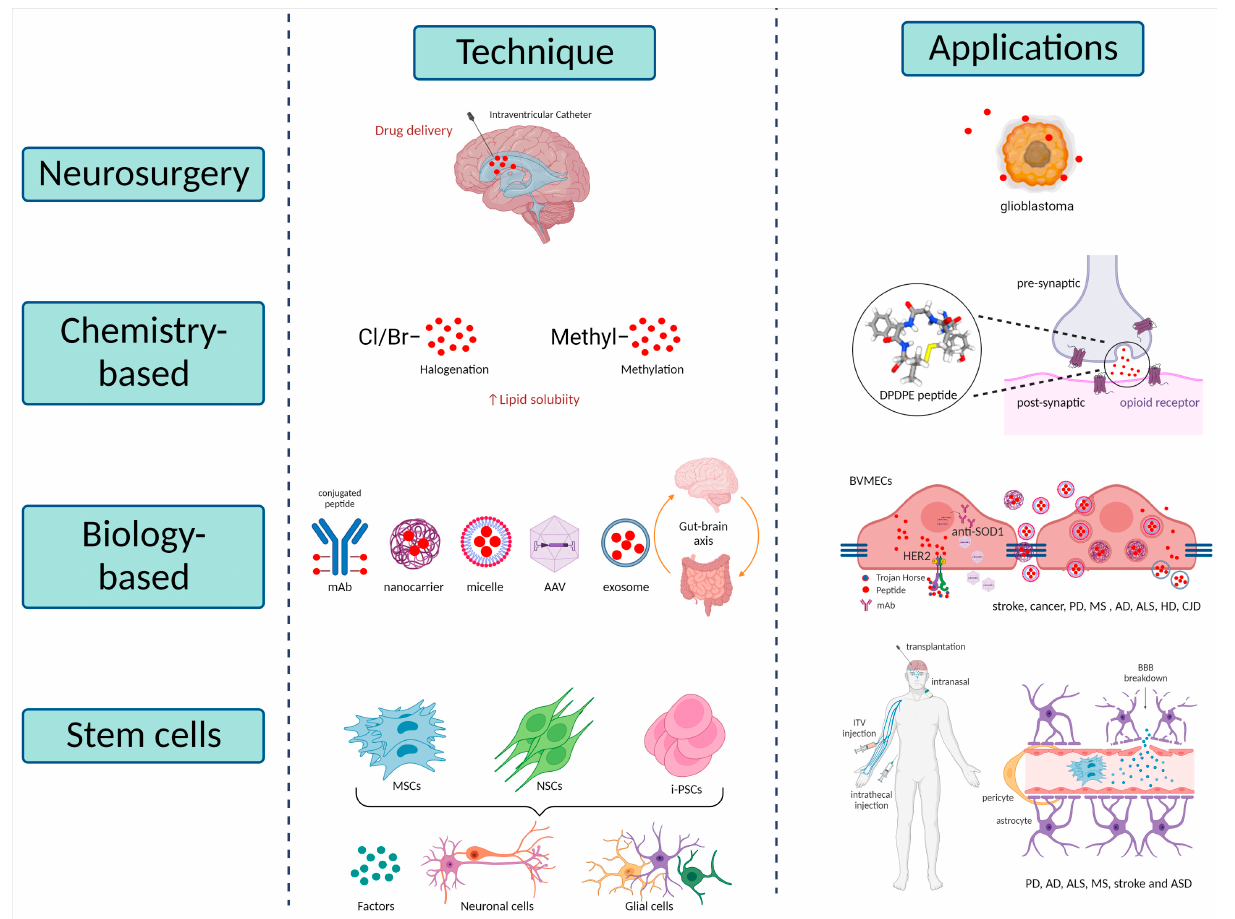
Figure 2. Main potential therapies and their most extended applications. The potential therapies described here are: neurosurgery [203,204], chemistry-based [202,205–207], biology-based [208–236] and stem cell-based [237–255] approaches. Due to the brain’s lack of a lymphatic system, the drugs administrated by neurosurgical techniques preferentially move along white matter tracts, thus are widely utilised in glioblastoma treatment. Chemistry-based therapies are made to increase drug solu- bility and targeting scope, such as lipophilicity modulation, halogenation or methylation. Chemical approaches and biology-based therapies, as Trojan Horse technology or exosomes administration are often combined to treat a wide range of neurological disorders. Stem cells can exert their therapeutic effects either through their neurotrophic capacity or through cell replacement. This figure has been designed as a summary of the Potential Therapies section; please refer to the text for further details. This figure was created using